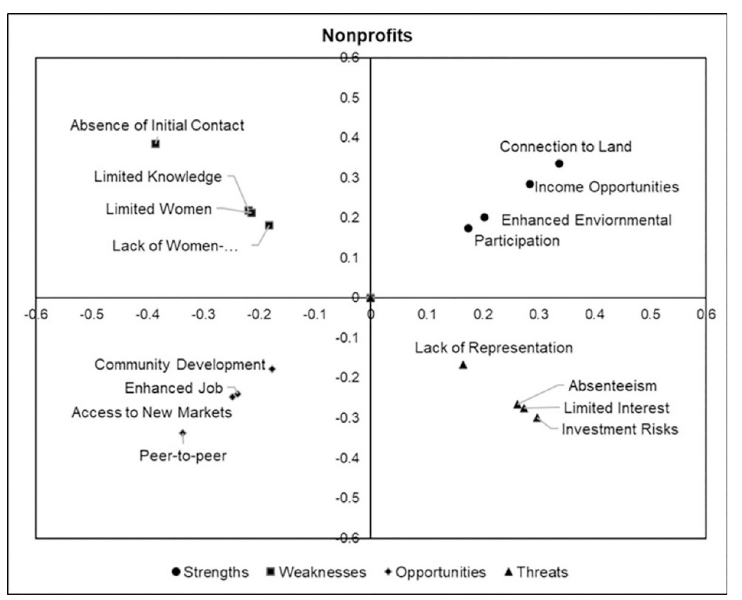
Fig 3. Perception map of factor priorities assigned by non-profit